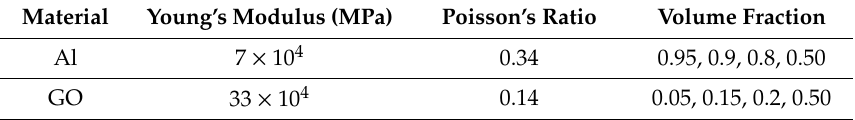
Table 1. Properties of materials used in graphene oxide (GO) / Al composite